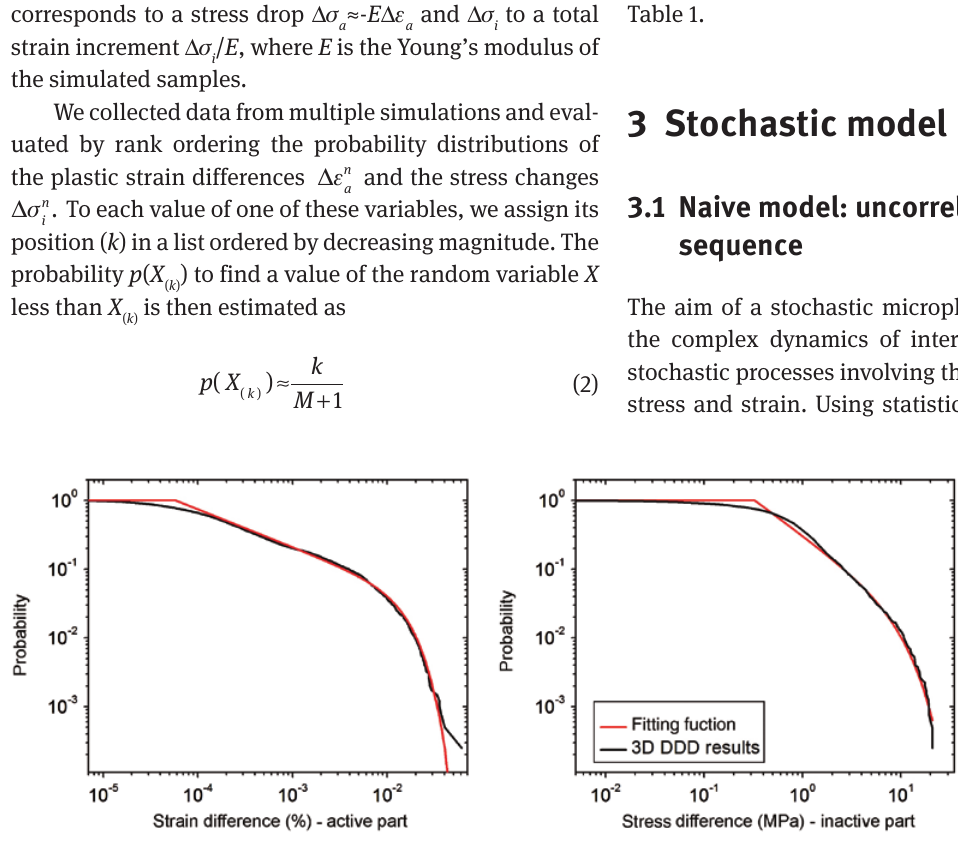
Figure 4: Left, rank-ordered distribution of plastic strain increments during strain bursts (“active” time intervals); right, distribution of stress increments during inactive time intervals, determined from 22 DDD simulations of uniaxial compression as described in the text. Black line corresponds to simulation data; red line corresponds to fitting